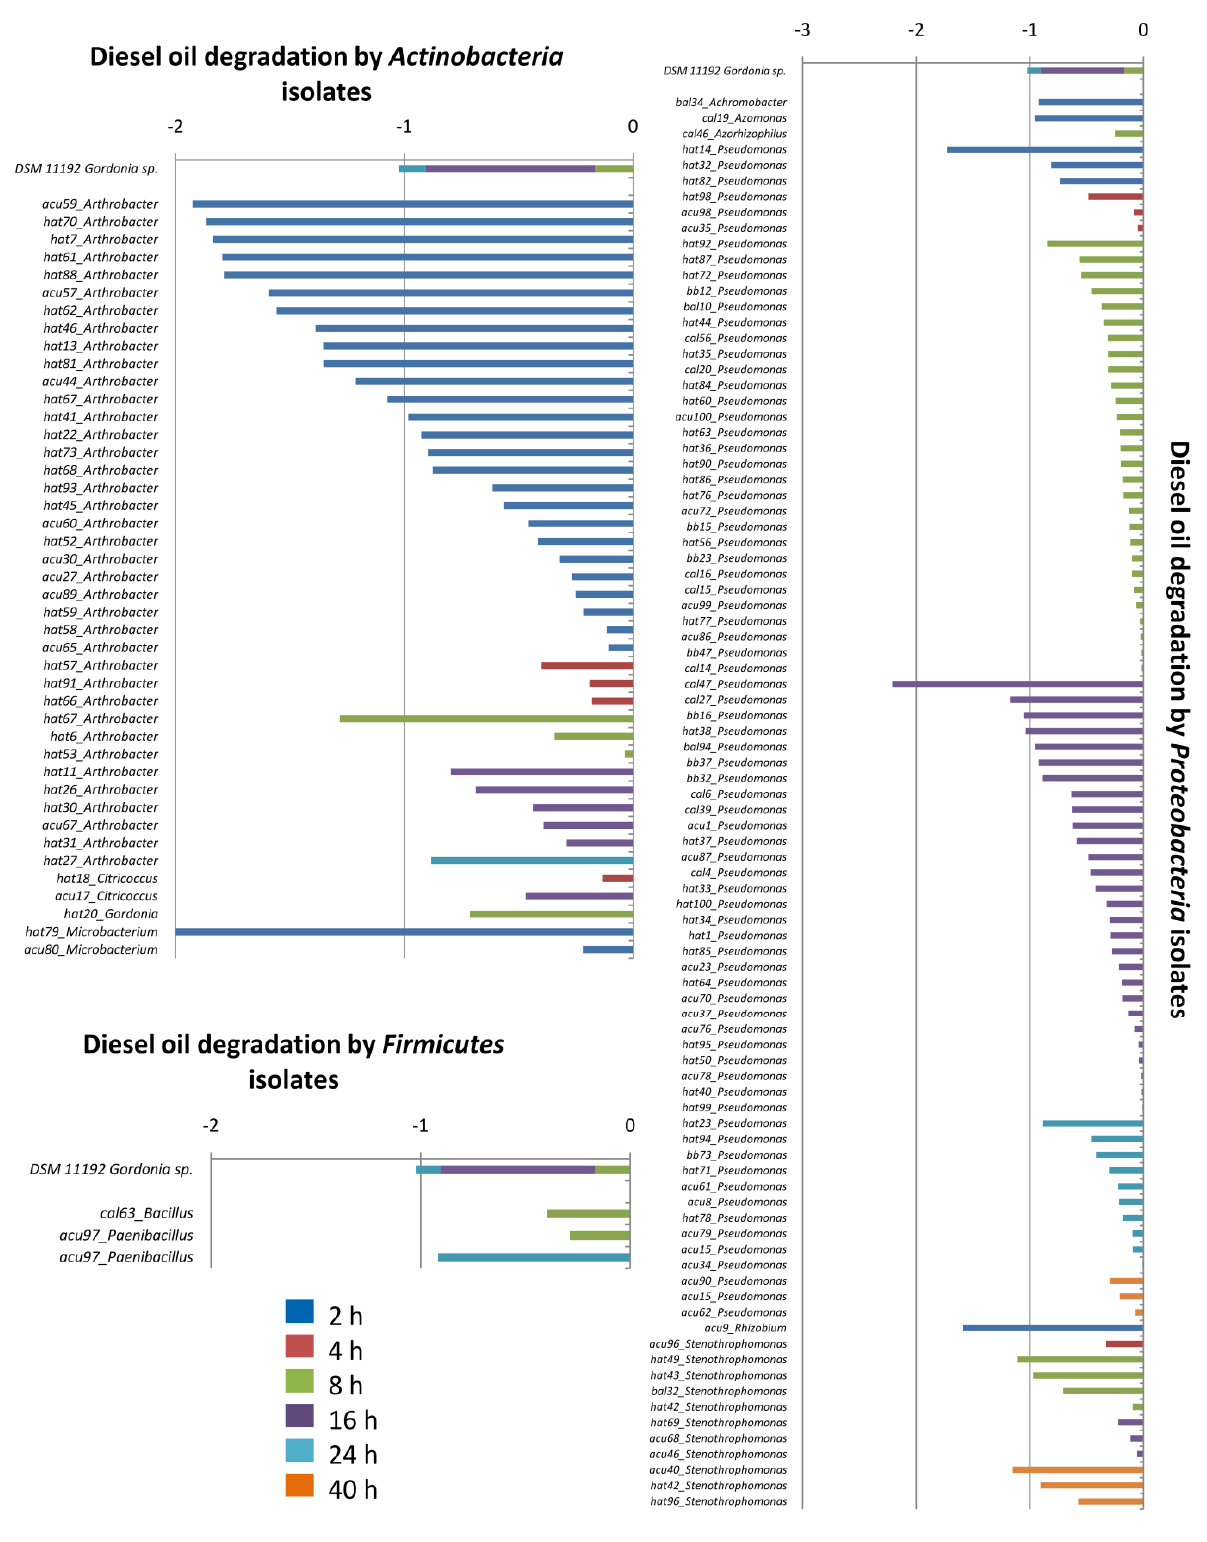
Figure 4. Visualization of the isolates based on their identification of the genus within the phyla for the degradation of 8% of diesel after 2 h, 4 h, 8 h, 16 h, 24 h and 40 h measured at 620 nm. Negative data indicate degradation. The positive control is at the top of the figure, and the genus of each isolate is shown. Each colored bar indicates the time of degradation for a determined degradation